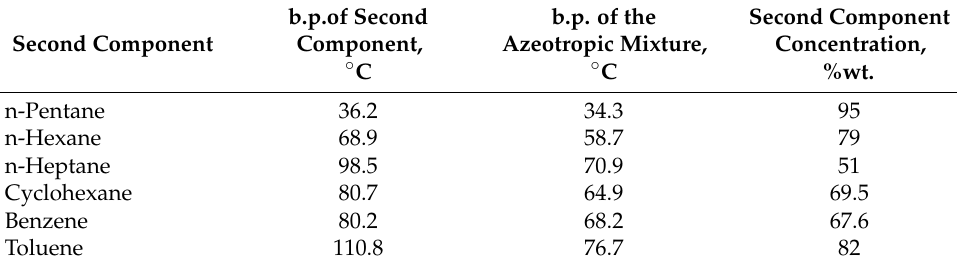
Table 3. Binary azeotropes of ethanol at atmospheric pressure (boiling point b.p. = 78.4 ◦ C). b.p.of Second Component